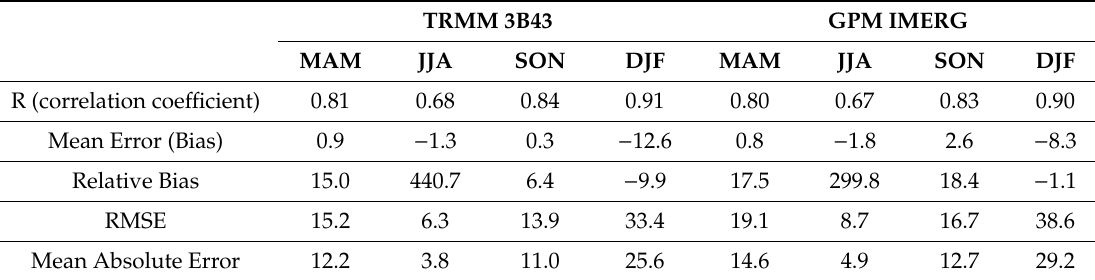
Table 3. Performance evaluation metrics of seasonal data from 3B43V7 and IMERG (the range of values is given in